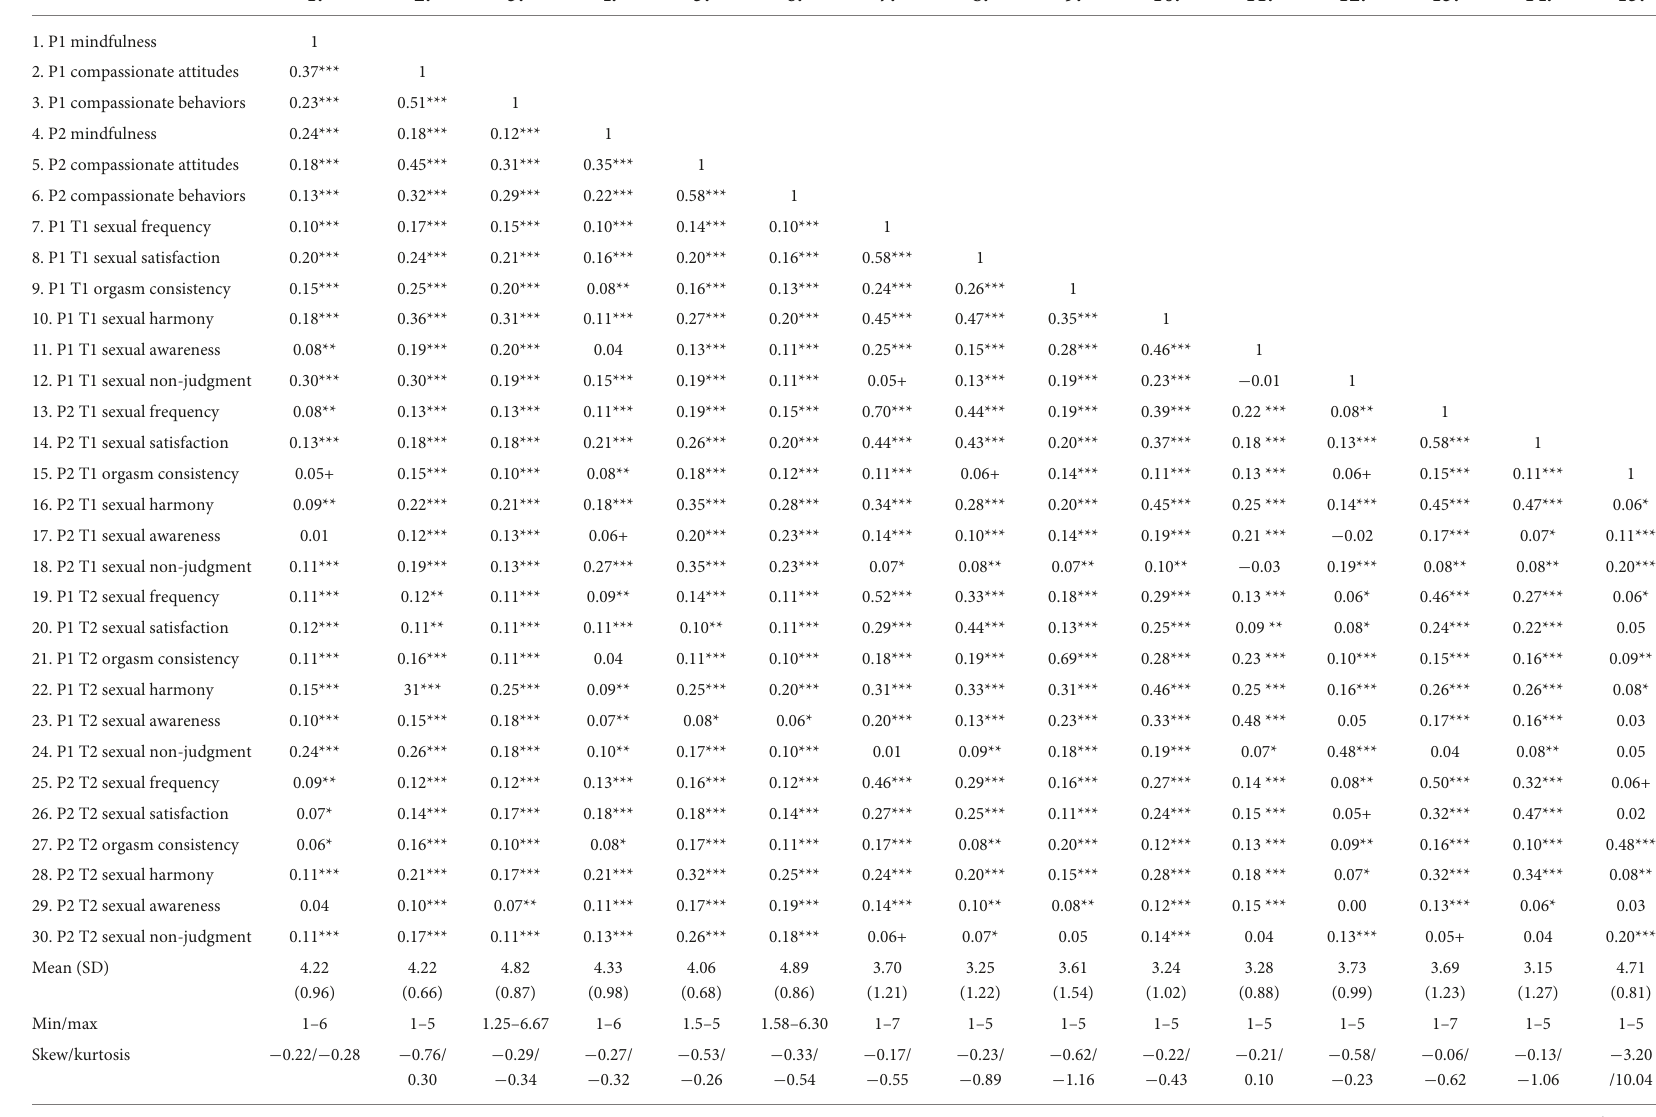
TABLE 1 Correlations and descriptive statistics for all study variables ( n =